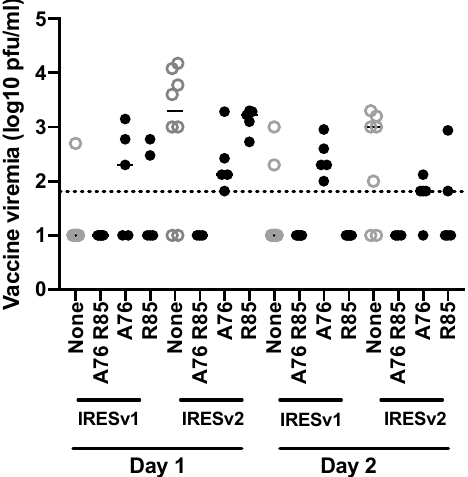
Figure 6. Viremia following vaccination with mutated ZPC/IRES vaccines. Individual data points are shown in log 10 -transformed titers. The mean is denoted by a bar in each group. ZPC/IRESv1 and ZPC/IRESv2 are included as grayed out open circles as a comparison from data in Figure 3B. Dashed line denotes limit of detection = 1.81 log 10 pfu/mL.